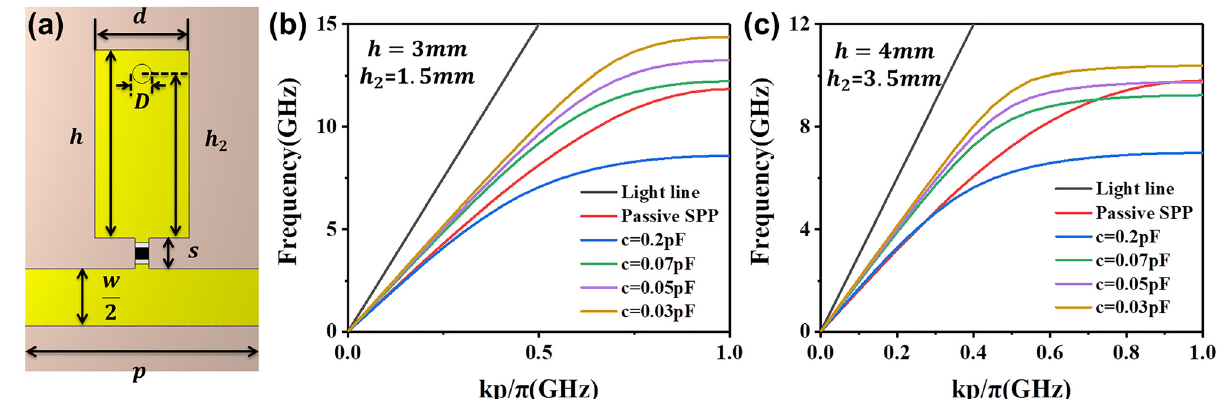
Figure 1: The active SSPP structure and its dispersion properties. (a) The active SSPP unit cell. (b) – (c) The simulated dispersion curves of the passiveSSPPunitandactiveSSPPunitwith(b) h =3mmand h 2 =1.5mm,and(c) h =4mmand h 2 =3.5mm,inwhichthecapacitance c =0.03, 0.05, 0.07 and 0.2 pF, respectively.